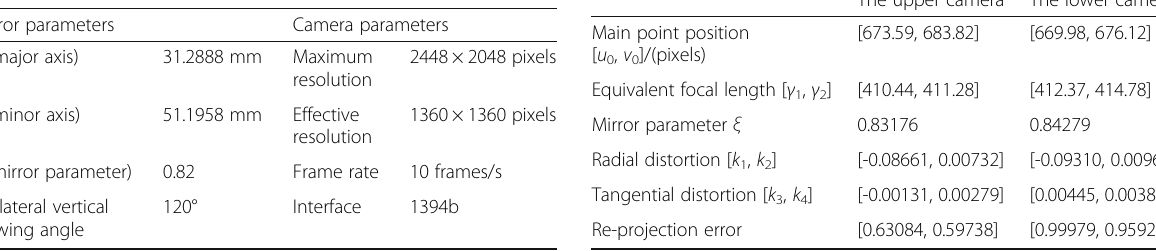
Table 2 Intrinsic calibration parameters of the omnidirectional